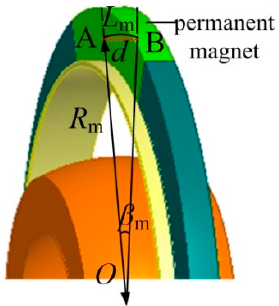
Figure 4. Permanent magnet.